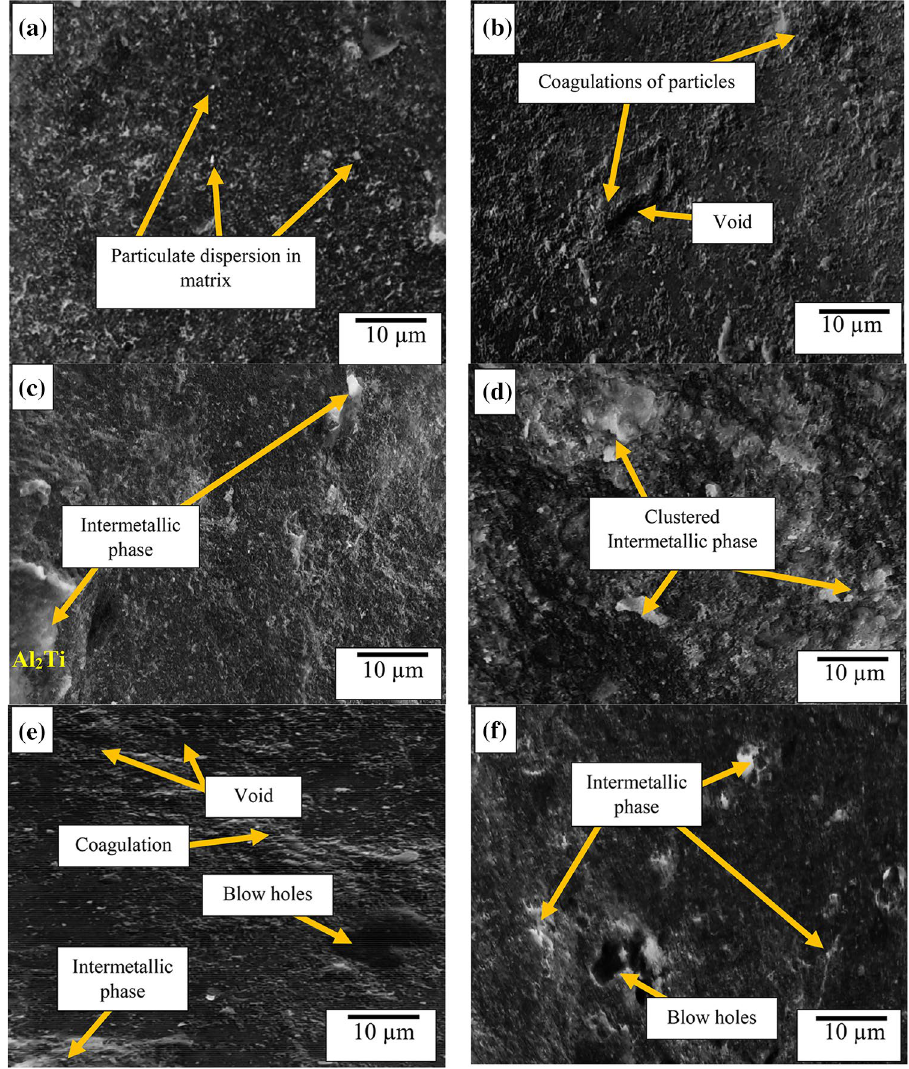
Figure 8. Microstructural images of developed composite showing different conditions of experimental runs at temperature, speed, and time values of ( a ) 700 °C, 500 rpm, 15 min; ( b ) 350 °C, 331.821 rpm, 10 min; ( c ) 868.179 °C, 500 rpm, 15 min; ( d ) 800 °C, 600 rpm, 20 min; ( e ) 800 °C, 600 rpm, 10 min; ( f ) 800 °C, 600 rpm, 20